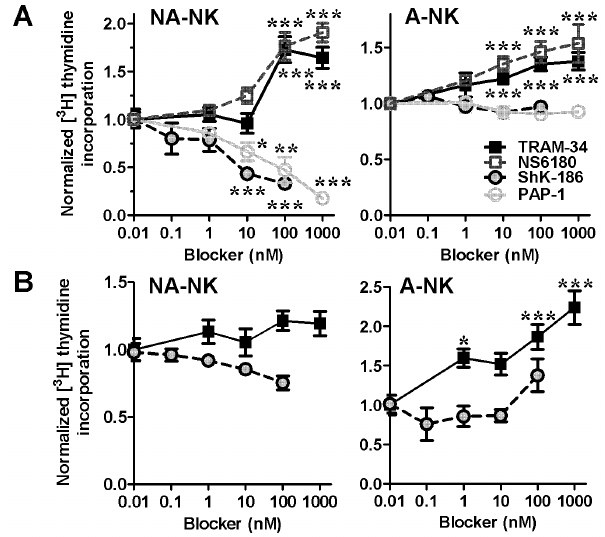
Figure 3. Blocking KCa3.1 and Kv1.3 differentially affects the proliferation of A-NK and NA-NK cells. Dose-dependent effects of N TRAM-34 ( & ; n=7 donors each analyzed in triplicates), NS6180 ( % ; ; n=7 donors each n=3 donors each analyzed in triplicates), ShK-186 ( analyzed in triplicates), and PAP-1 ( # ; n=7 donors each analyzed in triplicates) on [ 3 H] thymidine incorporation by NA-NK and A-NK stimulated with PMA and ionomycin alone ( A ) or in addition to rhIL-2 and rhIL-15 ( B ). Data represent the mean 6 SEM. *p , 0.05, **p , 0.01, ***p , 0.001.